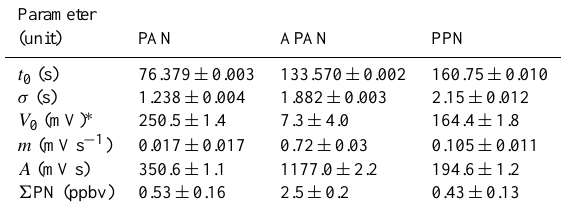
Table 1. Parameters of Eq. (1) fitted to the top three chromatograms in Fig. 5a. The fit uncertainties are those estimated using built-in al- gorithms in the Igor Pro 6 software package. The uncertainty stated for 6 PN is the 1 σ measurement precision. Concentrations of impu- rities were not